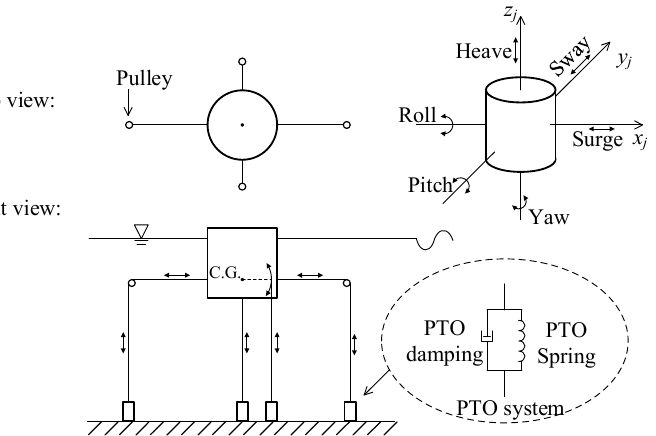
Figure 1. Definition of the six degrees of freedom of a single floating cylinder and a concept sketch of the power take-off (PTO) system.